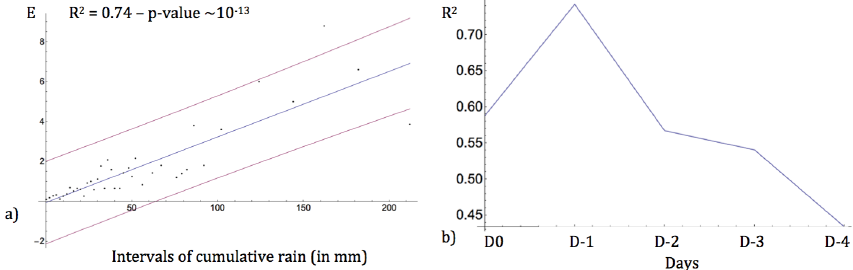
Figure 7. Réunion; (a) application of the method to cumulative rainfall over two days ( D 0 + D 1 ); (b) R 2 of rockfall vs. rain accumulated over several days.